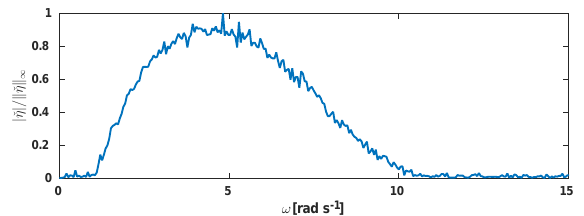
Figure 7. The normalized spectral shape of the influx signal for the case